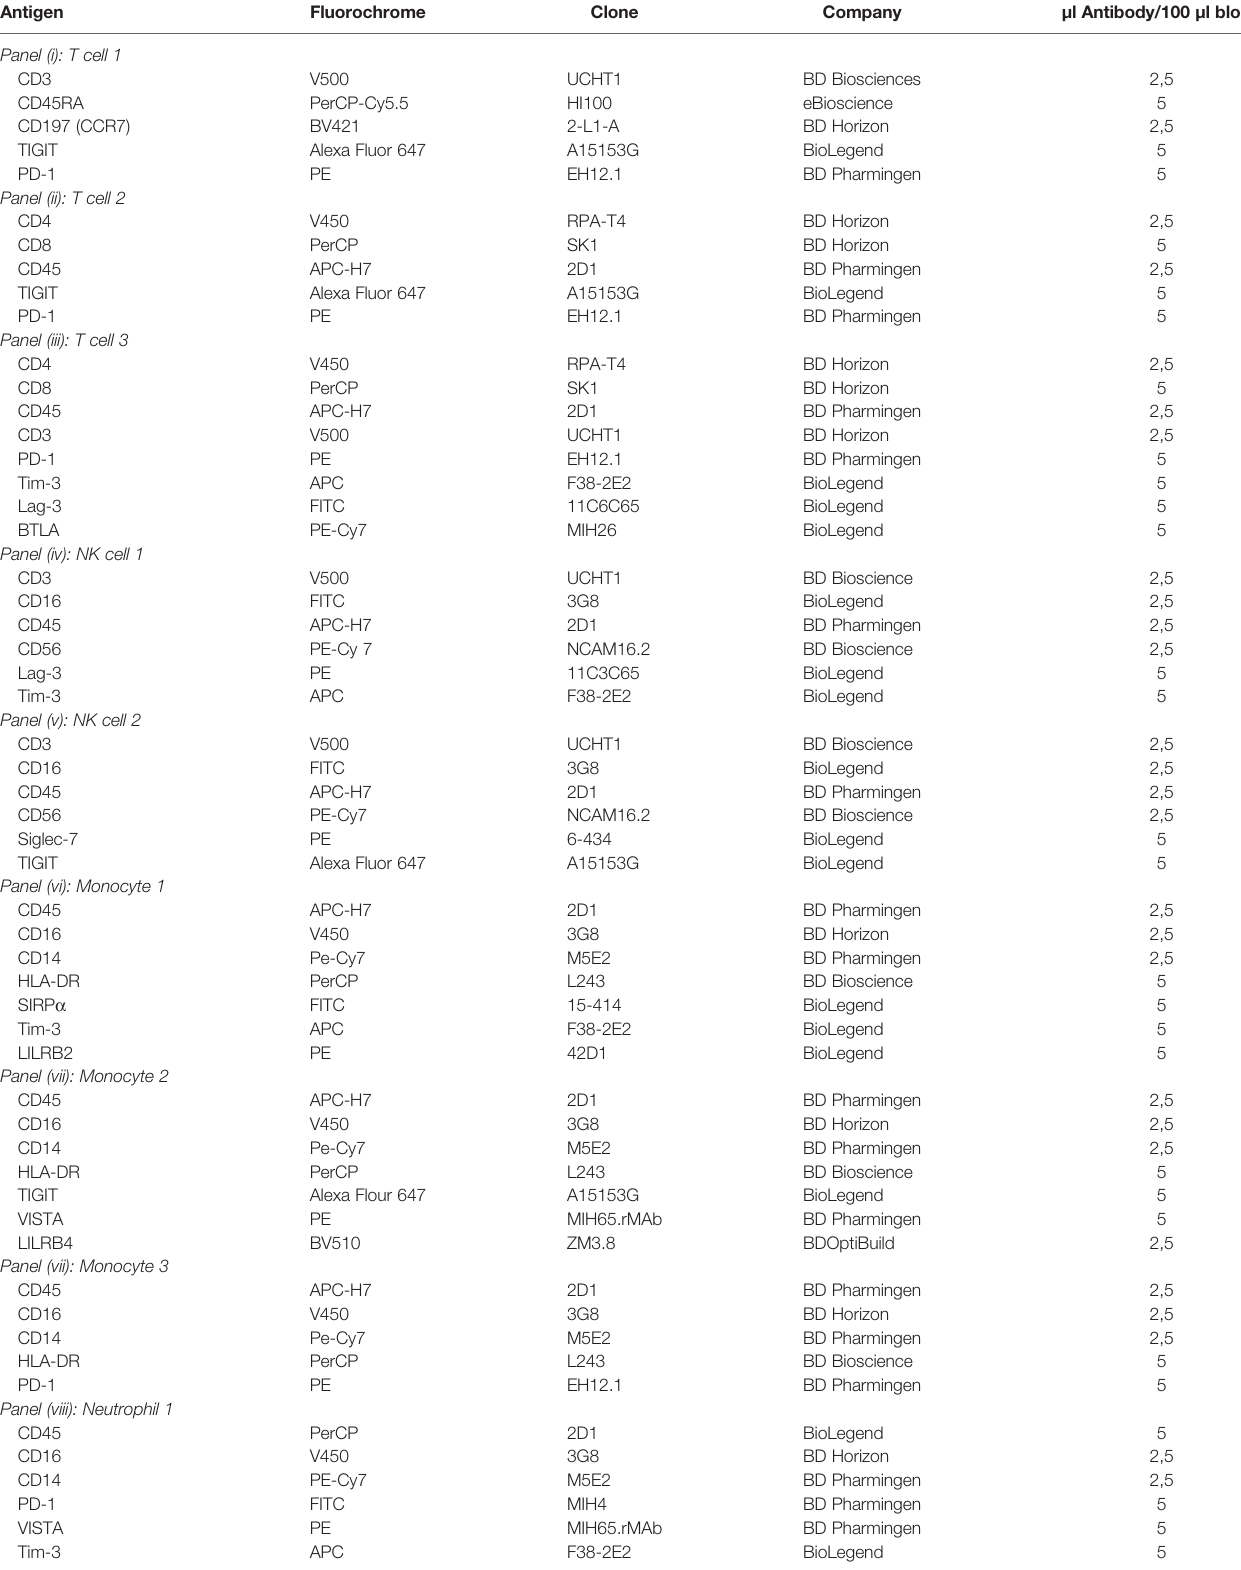
TABLE 1 | Panel description and speci fi cation of antigens, fl uorochromes, clones, distributors, and quantity of antibodies used for staining of 100 µl whole blood. Antigen Panel (i): T cell 1 CD3